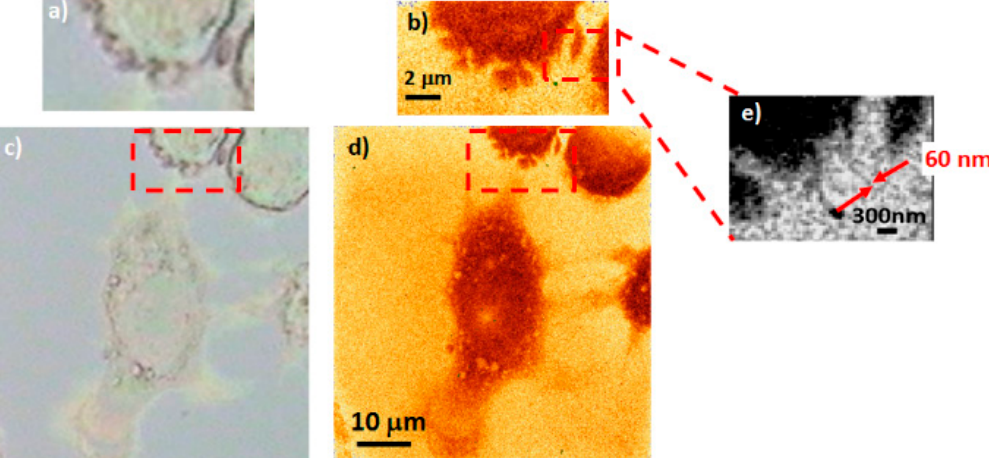
Figure 17. CT 26 fibroblasts from Mus musculus mouse colon carcinoma (strain BALB/c). Images acquired with visible light microscopy ( a , c ) and SXR ( b , d , presented in false colors). The internal structure is observable in ( a , c ) due to a phase-contrast and in ( b , d ) due to the modulation in the transmittance of the SXR radiation through the sample. The SXR images show enhanced spatial resolution and high absorption contrast. The zoomed image in ( e ) shows small features, approaching the half pitch spatial resolution of the SXR microscope ( ∼ 60 nm). Acquisition parameters: 600 SXR pulses, 1 min. exposure. Figure modified, based on [77].